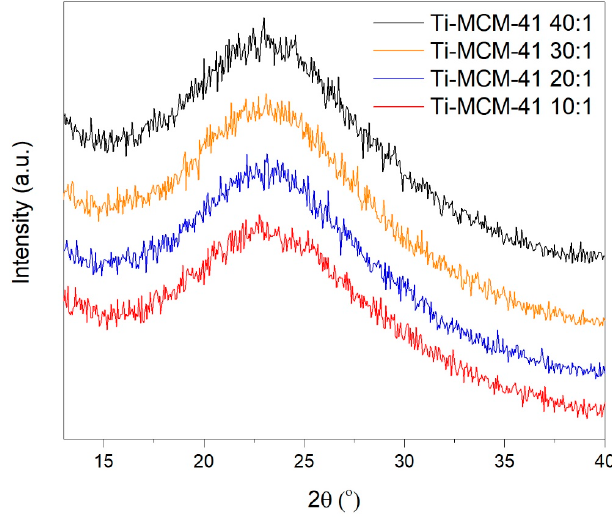
Figure 3. High-angle X-ray diffraction data for Ti-MCM-41 samples with different molar ratios of Si:Ti in the crystallization gel (respectively, 40:1, 30:1, 20:1, and 10:1).